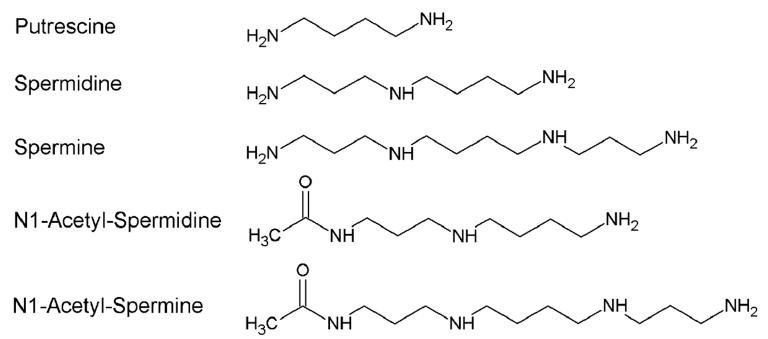
Figure 1. Polyamines and their acetyl derivatives.